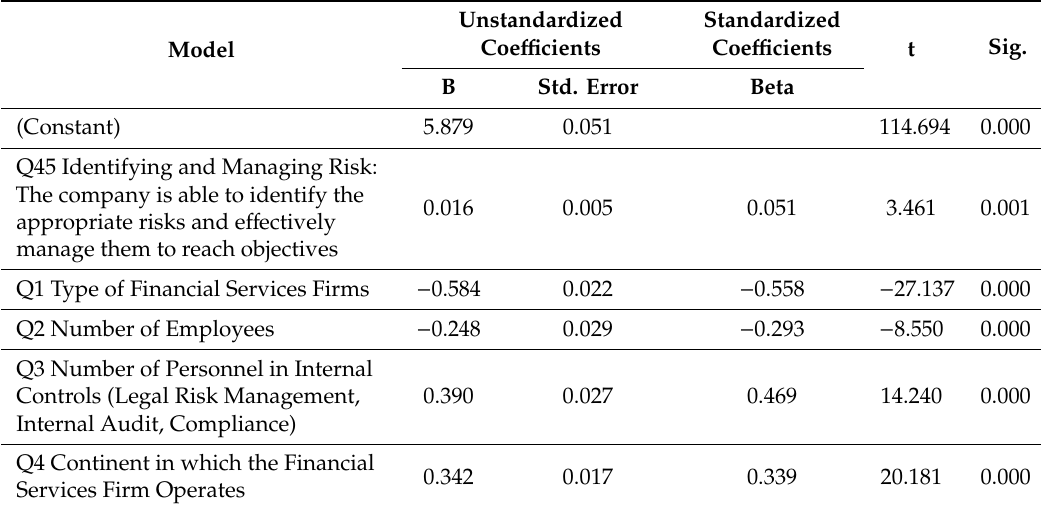
Table 6. Coe ffi cients a